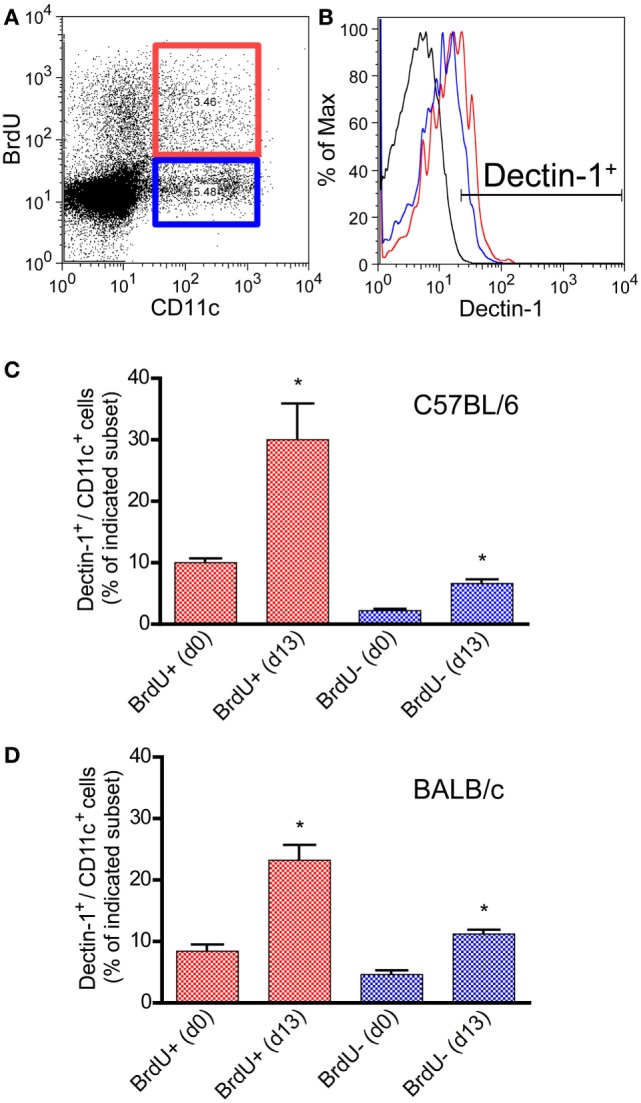
Characterization of Dectin-1 expression on proliferating CD11c+ DCs in blood samples of infected C57BL/6 and BALB/c mice. Mice were infected intradermally with Leishmania major parasites into the hind footpad, and the peripheral blood was analyzed 13 days after infection. Naïve mice served as controls (day 0). BrdU+ was given 3 days before the analysis. Peripheral blood leukocytes were gated. (A) The dot plot diagram displays the CD11c and BrdU intensities. BrdU+/CD11c+ cells are highlighted by a red and BrdU−/CD11c+ by a blue gate. (B) Dectin-1 expression of the BrdU subsets is shown as histogram displaying isotype control in black, BrdU+/CD11c+ cells in red, and BrdU−/CD11c+ cells in blue line. (C) The frequencies of Dectin-1+/CD11c+ cells (blue bars, BrdU−/CD11c+; red bars, BrdU+/CD11c+) within the peripheral blood of C57BL/6 mice were analyzed. Pooled data from three different experiments are shown (mean ± SD). Data were analyzed using Student’s t-test (**p = 0.004, ***p = 0.0003). (D) The frequencies of Dectin-1+/CD11c+ cells (blue bars, BrdU−/CD11c+; red bars, BrdU+/CD11c+) within the peripheral blood of BALB/c mice are indicated (mean ± SD). Pooled data from three different experiments were analyzed using the non-parametric Mann–Whitney test (*p < 0.5).